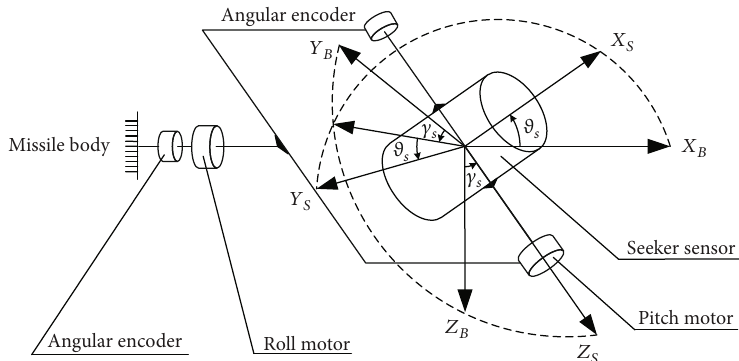
Figure 1: Roll-pitch gimbaled seeker con fi guration.